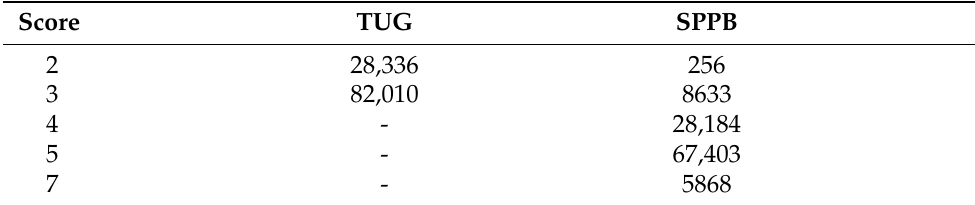
Table 5. This table shows the number of windows for participant 19 who was excluded from the training set. Score 2 of the SPPB were not considered for evaluation, because the model for the SPPB was not trained with class 2.